Question: Write the caption for this figure.
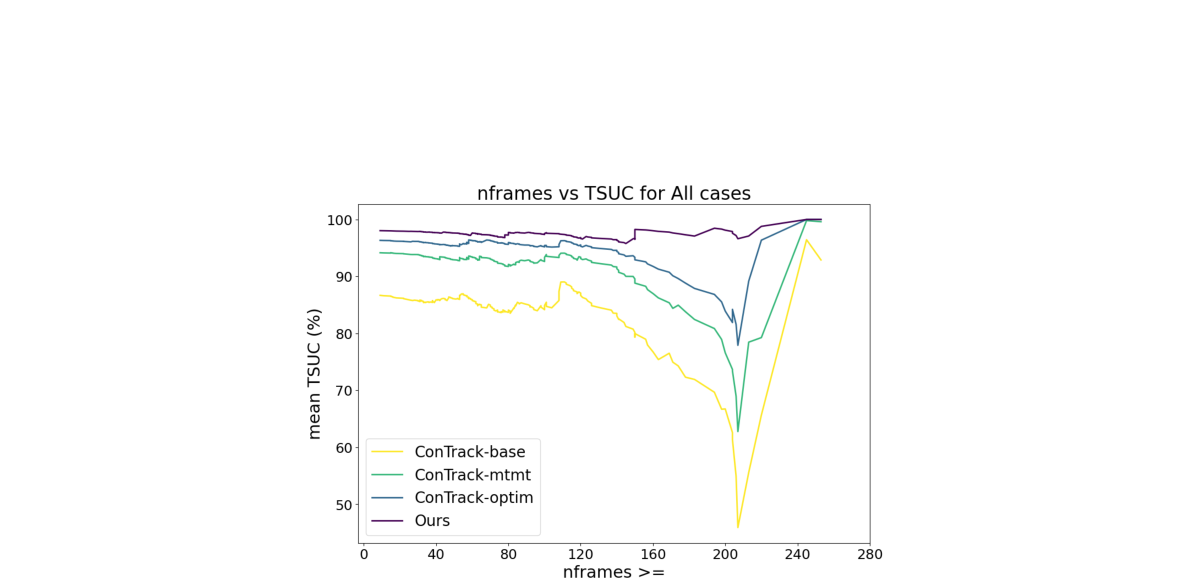
Answer: Robustness with respect to the sequence length: mean TSUC for all sequences greater than the frame count (nframes). Note the dataset consists of only 4 sequences with frame count greater than 210.